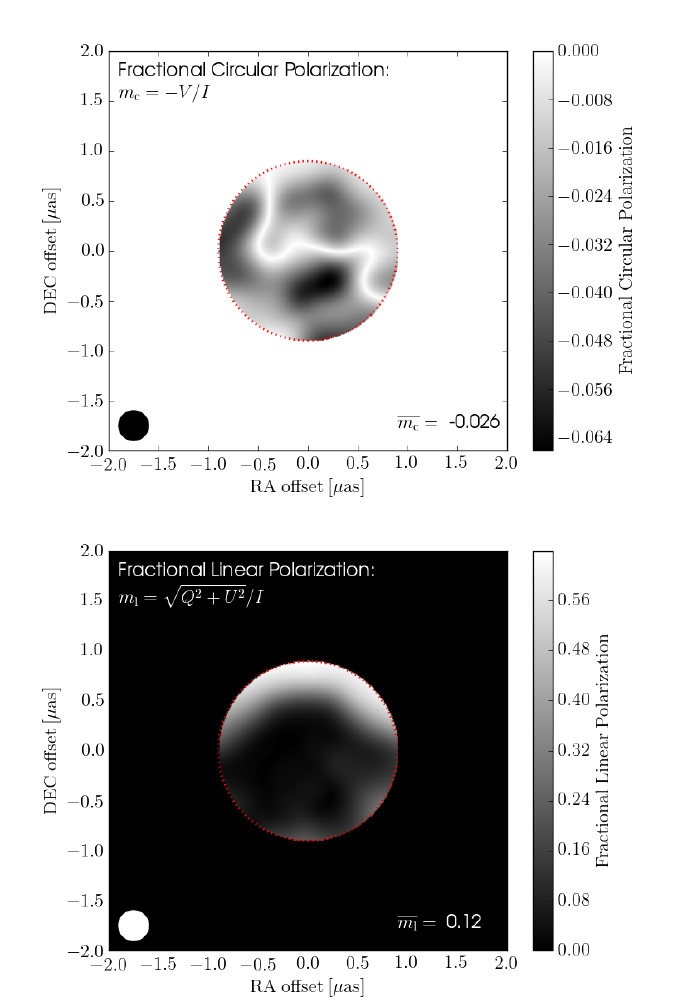
Figure 6. ( Upper panel )—A rendering of the linearly polarized intensity of the disordered TEMZ grid, as seen at an observing frequency of 43 GHz. The electric vector position angles (EVPAs) illustrate the orientation of the linearly polarized emission as projected onto the plane of the sky, and are shown as black line segments. The effects of relativistic aberration (as outlined in [7]) on the orientation of these EVPAs have been included in my radiative transfer calculations. ( Middle panel )—A plot of the observed fractional circular polarization with an integrated value ( m c ) shown in the lower right. ( Lower panel )—A plot of the observed fractional linear polarization with an integrated value ( m l ) shown in the lower right. The above images have all been convolved with the circular Gaussian beam, shown in the lower